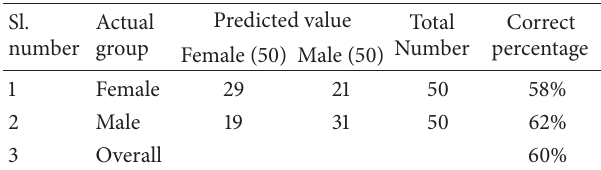
Table 10: Predictive value using all dimensions and directions.